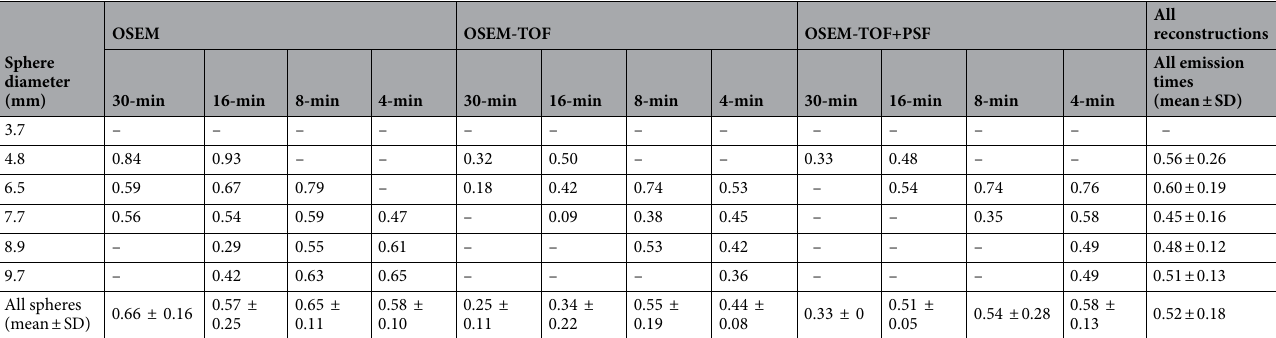
Table 4. MDA-Ratios between the Vision and the mCT for each sphere size, reconstruction algorithm, and emission time. No values are indicated, if the MDA was outside the range that can be evaluated within this